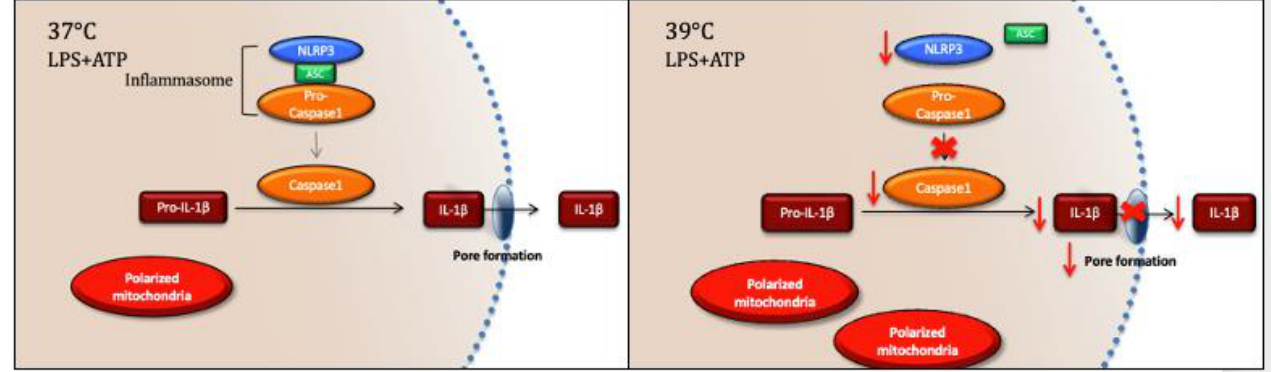
Figure 5. Exposure to a mildly elevated temperature of 39 °C leads to rapid inhibition of inflam- masome activation, associated with decreased caspase 1 and IL-1β processing, decreased plasma membrane permeability, decreased ASC speck formation, and increased numbers of polarized mi- tochondria.